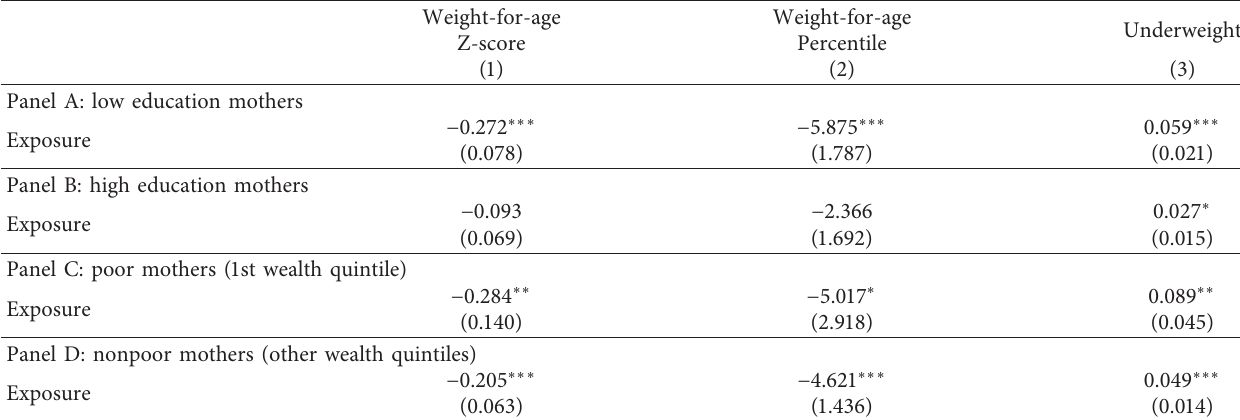
Table 7: Exposure to armed conflict on child weight-for-age